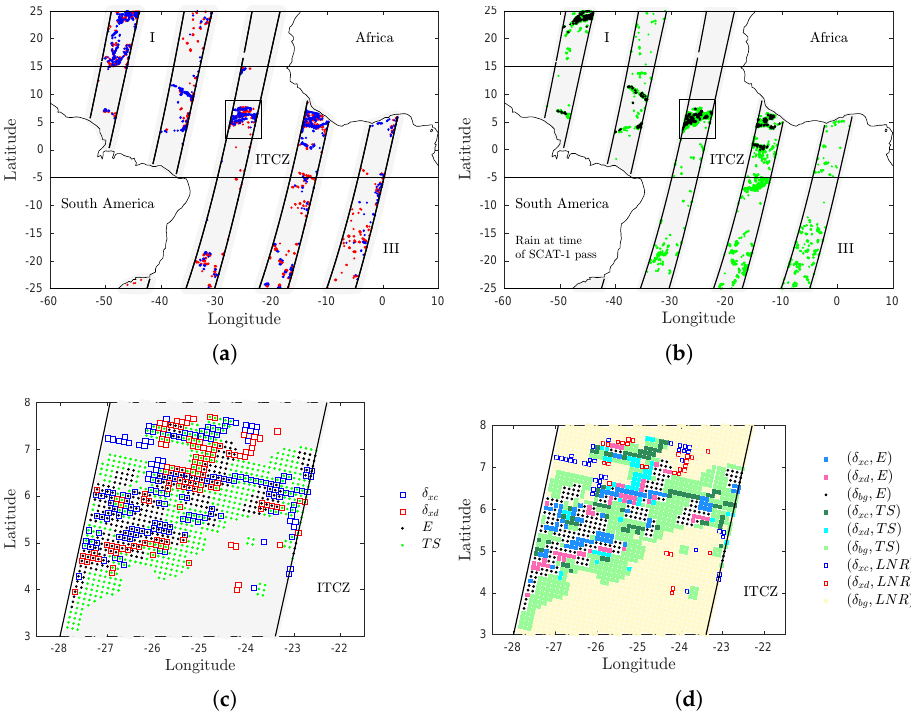
Figure 9. Spatial patterns of extremes. ( a ) Extremes of convergence (blue) and divergence (red); ( b ) rain extremes (black) and transition/stratiform rain (green). Rain extremes are from field of view of ASCAT at time of the satellite pass. Times of five swaths are, from left-to-right, 09:45, 10:30, 11:15, 12:00, and 13:00 UTC. ( c , d ) Magnification of swath within the small rectangle in ( a , b ): ( c ) coinciding extremes. ( d ) Segmentation into subsets of co-occurring points defined by thresholds in Tables 2 and